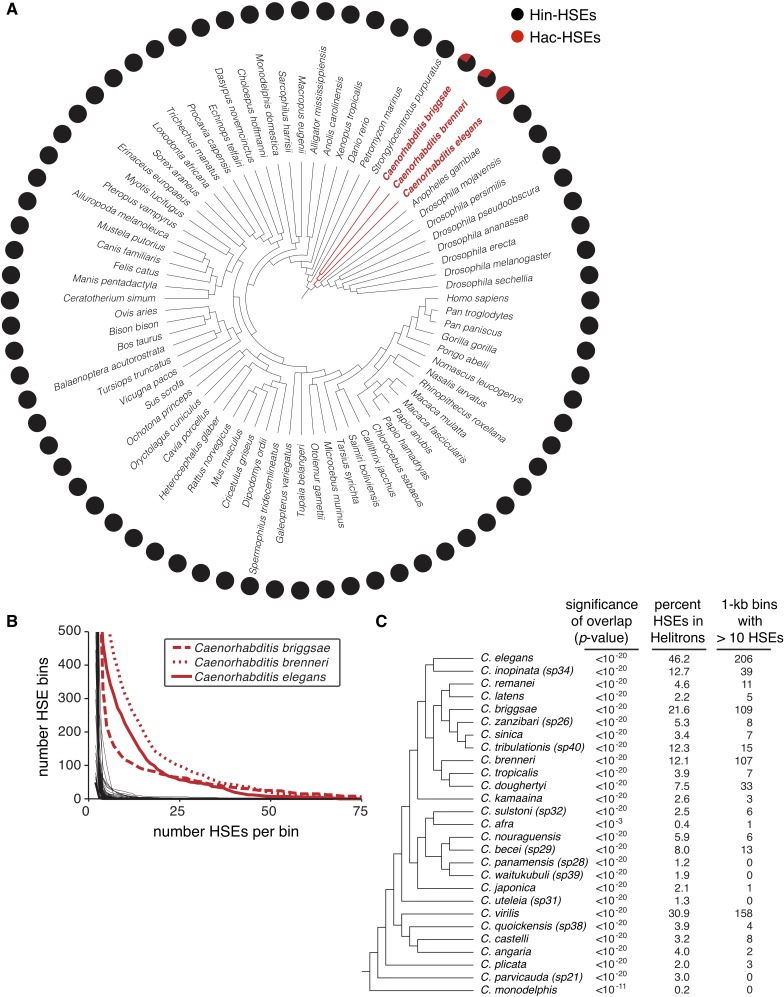
Helitrons contribute significant numbers of HSEs to other Caenorhabditis genomes.(A) Phylogeny of all metazoan genomes hosted at the UCSC genome browser (genome.ucsc.edu) that have RepeatMasker-generated annotations of repetitive elements (see Supplementary file 5 for genome assembly IDs). Adjacent pie charts display the proportion of total HSEs that reside within (red) or outside of (gray) annotated Helitrons. To prevent possible species-specific biases found in HSEs from influencing our results, we scanned for HSEs using the canonical species-independent sequence NGAANNTCCNNGGAN and its reverse complement (Perisic et al., 1989). Names of species with significant HSE-Helitron overlap (cumulative binomial distribution with p-value<0.001, see Supplementary file 5) are highlighted in red. (B) Cumulative distribution analysis of the density of HSEs for the genomes shown in panel A. The number of HSEs per 1 kb window (bin) in each genome was determined. Curves are plotted as the number of bins with a value that is greater than or equal to the indicated numbers of HSEs per bin. The three Caenorhabditis genomes that show numerous 1 kb windows with large numbers of HSEs per bin are highlighted in red. (C) Phylogeny of species hosted at the Caenorhabditis Genomes Project (http://www.caenorhabditis.org) that have RepeatMasker-generated annotations of repetitive elements (see Supplementary file 6 for genome assembly IDs). Next to each species name is the statistical significance of HSE/Helitron overlap (cumulative binomial probability), proportion of total HSEs found to overlap with Helitrons, and number of 1 kb windows with greater than 10 HSEs per window. Complete data are found in Supplementary file 6.